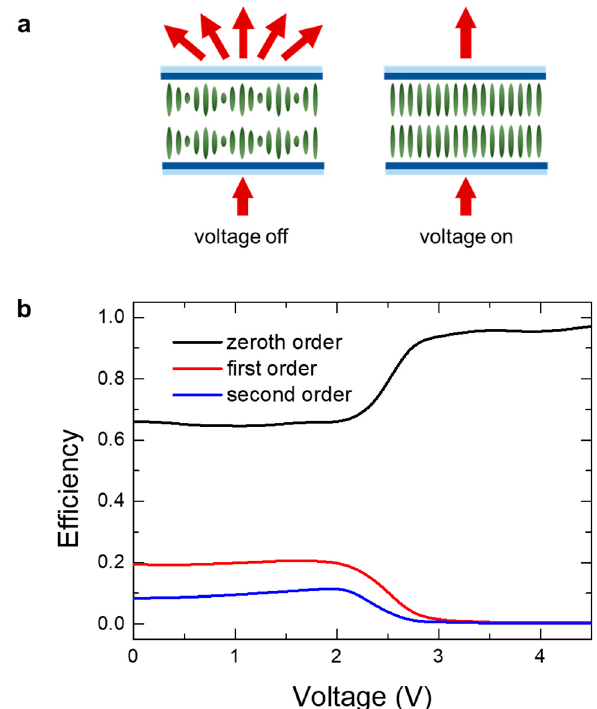
Figure 7. ( a ) Schematic representation of ULH polarization grating. ( b ) The measured voltage- dependent diffraction efficiency for each diffraction order of the fabricated ULH cell with a cell gap and the pitch length of 3.5 and 1.25 μ m, respectively.